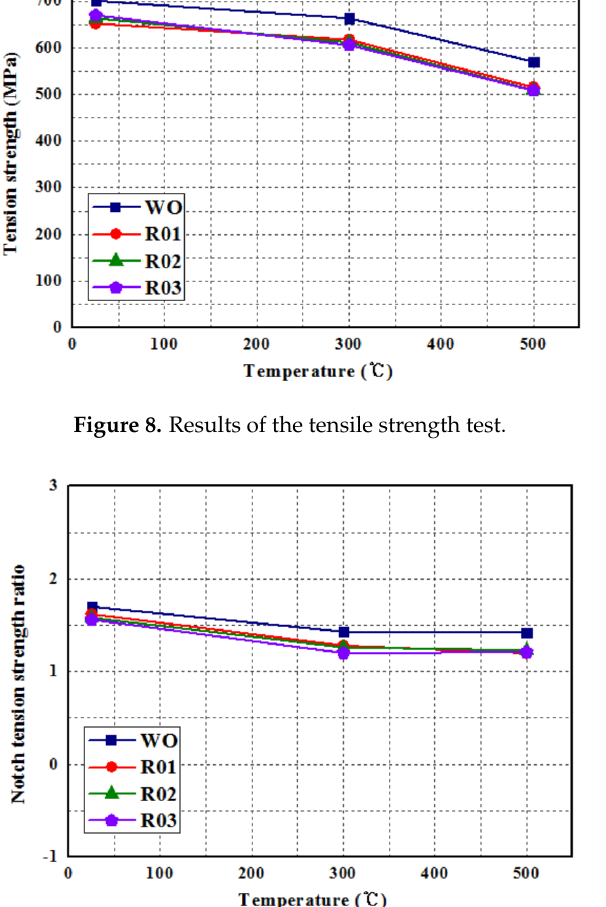
( b ) Figure 10. Optical image of Ti ‐ 3Al ‐ 2.5V pipe weldment: ( a ) weld metal; ( b ) heat affected zone.